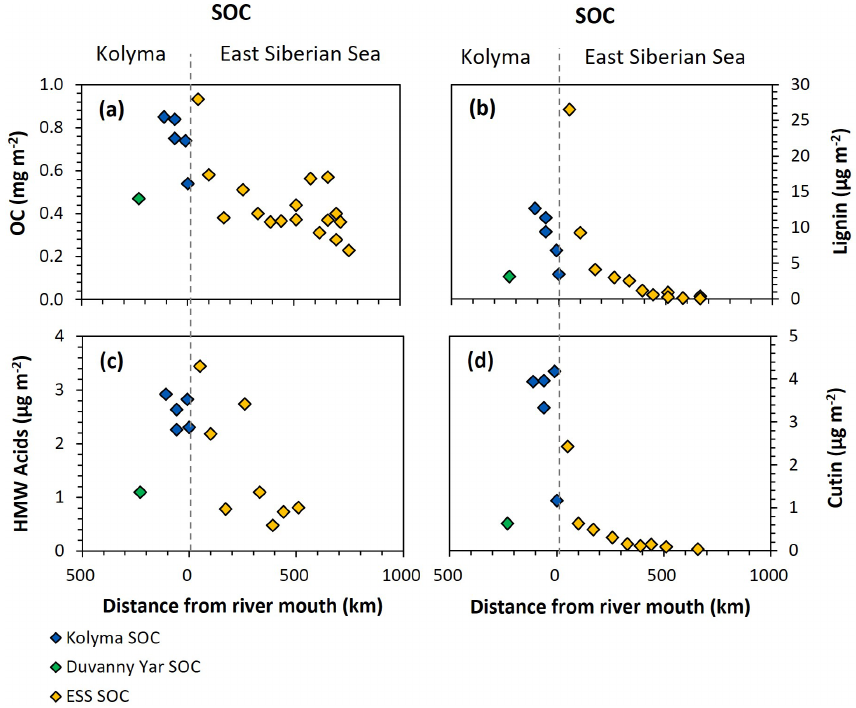
Figure 6. Organic carbon (OC) and biomarker concentrations normalised to mineral surface area over transect distance for the Kolyma (blue), Duvanny Yar (green), and East Siberian Sea (ESS; yellow) sediment organic carbon (SOC) samples. (a) OC concentrations (mgm − 2 ) , (b) Lignin concentrations (µgm − 2 ), (c) Cutin concentrations (µgm − 2 ), and (d) HMW n -alkanoic acids (C24–C30) concentrations (µgm − 2